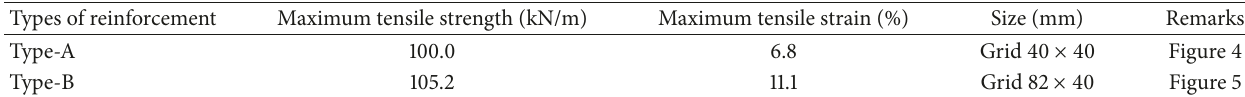
Table 4: Physical properties of reinforcements used for